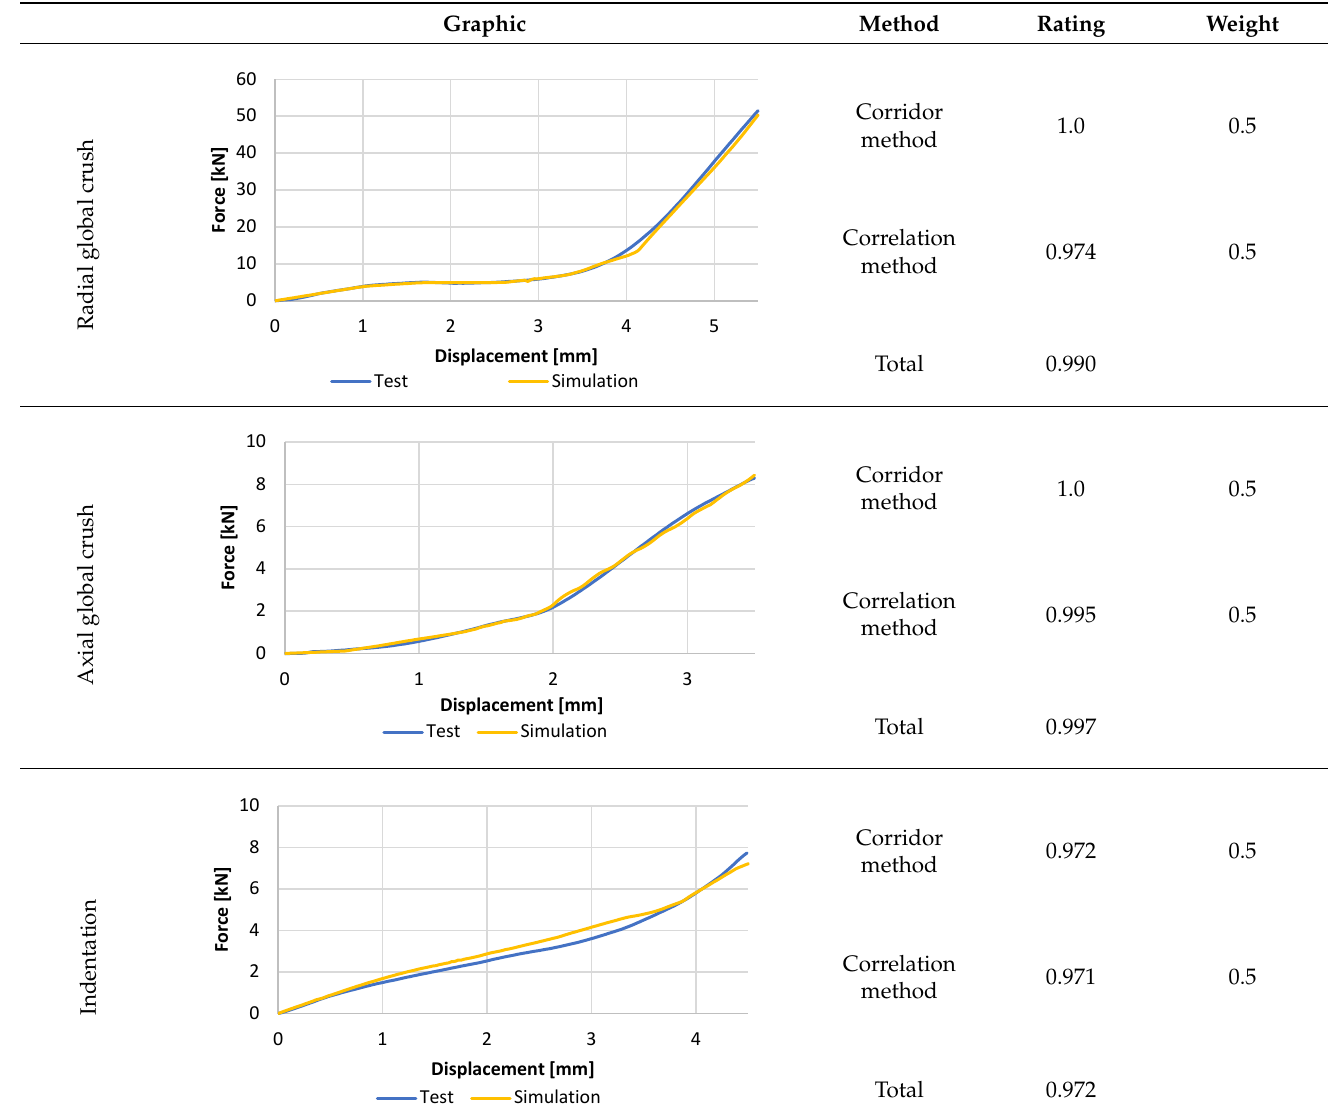
Table A1. Comparison of the force-displacement curves of the FE model and experimental tests for cell A and results of the CORA evaluation. Method Graphic Method Rating Weight